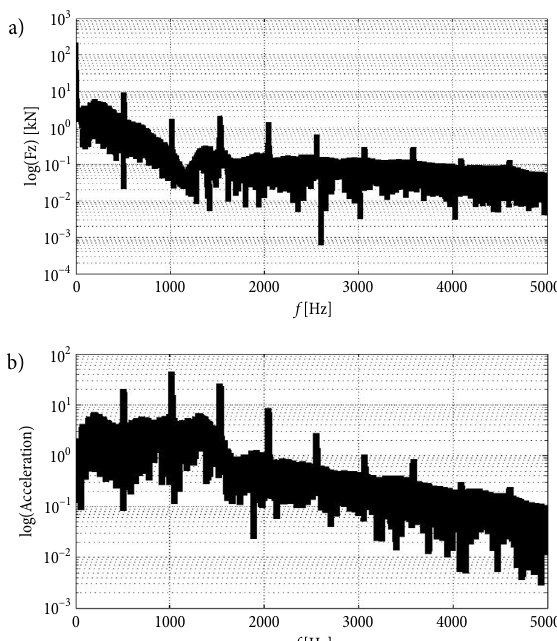
Fig. 13. Parameters occurring in contact between the vehicle’s wheel flat and the rail: a – amplitude of the vertical force; b – amplitude of wheel set acceleration